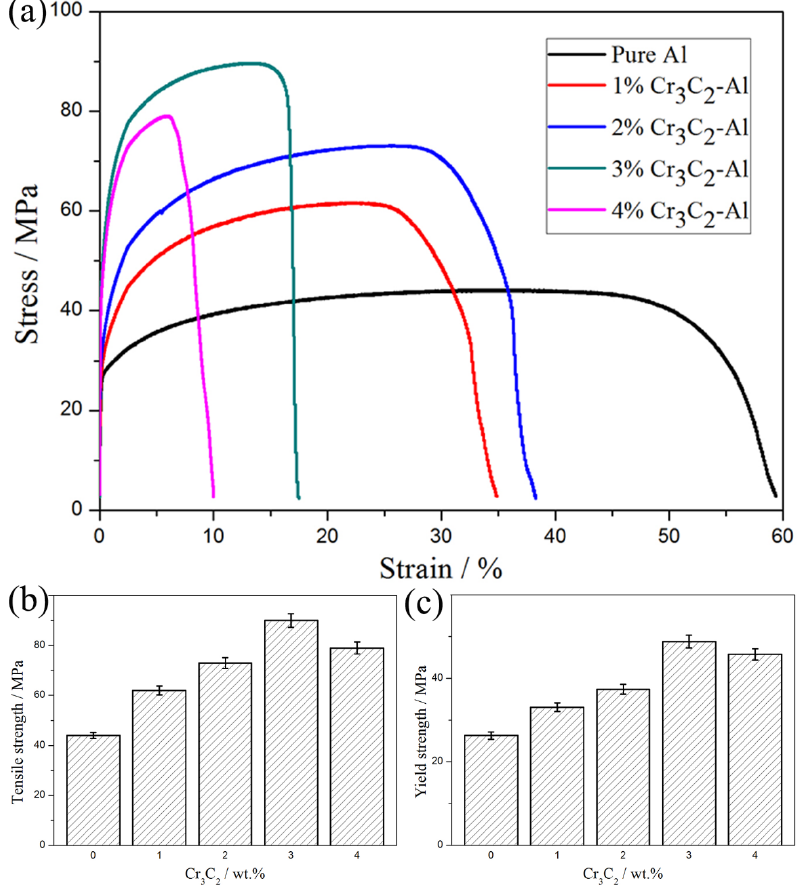
Figure 6. The stress-strain curves, tensile strength, and yield strength of the Cr 3 C 2 particle-reinforced Al matrix composite with different Cr 3 C 2 amounts added: ( a ) stress–strain curves, ( b ) tensile strength and ( c ) yield strength.